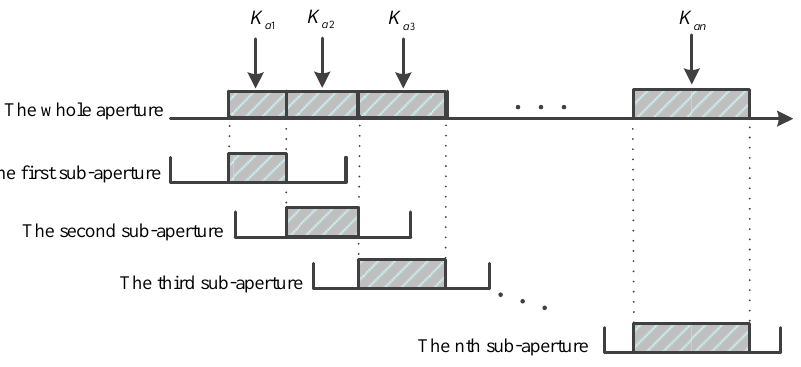
Figure 3. Schematic diagram of improved spectrum fusion method.